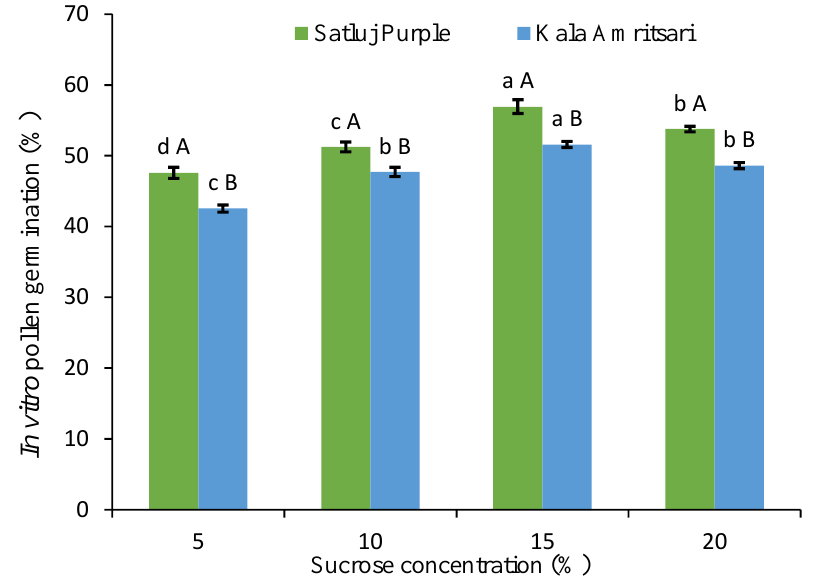
Figure 2. In vitro pollen germination under different sucrose concentration. Data are mean values from the 2018 and 2019 pollen. Separately for each cultivar, different lowercase letters indicate significant differences between sucrose concentrations according to the Tukey’s HSD test. Separately for each sucrose concentration, different uppercase letters indicate significant differences between sucrose concentrations according to the Tukey’s HSD